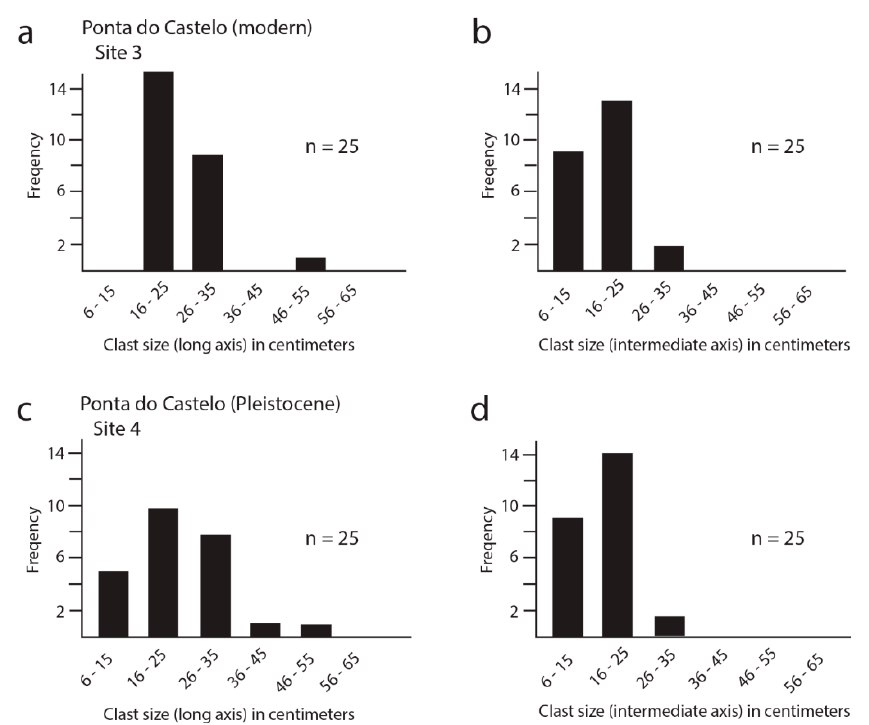
Figure 7. Bar graphs used to appraise variations in the long and intermediate axes on basalt clasts from modern and Pleistocene CBDs at Ponta do Castelo; ( a ) Long-axis length from clasts in the modern CBD; ( b ) Intermediate-axis length from clasts in the modern CBD; ( c ) Long-axis length from clasts in the Pleistocene CBD; ( d ) Intermediate-axis length from clasts in the Pleistocene CBD.